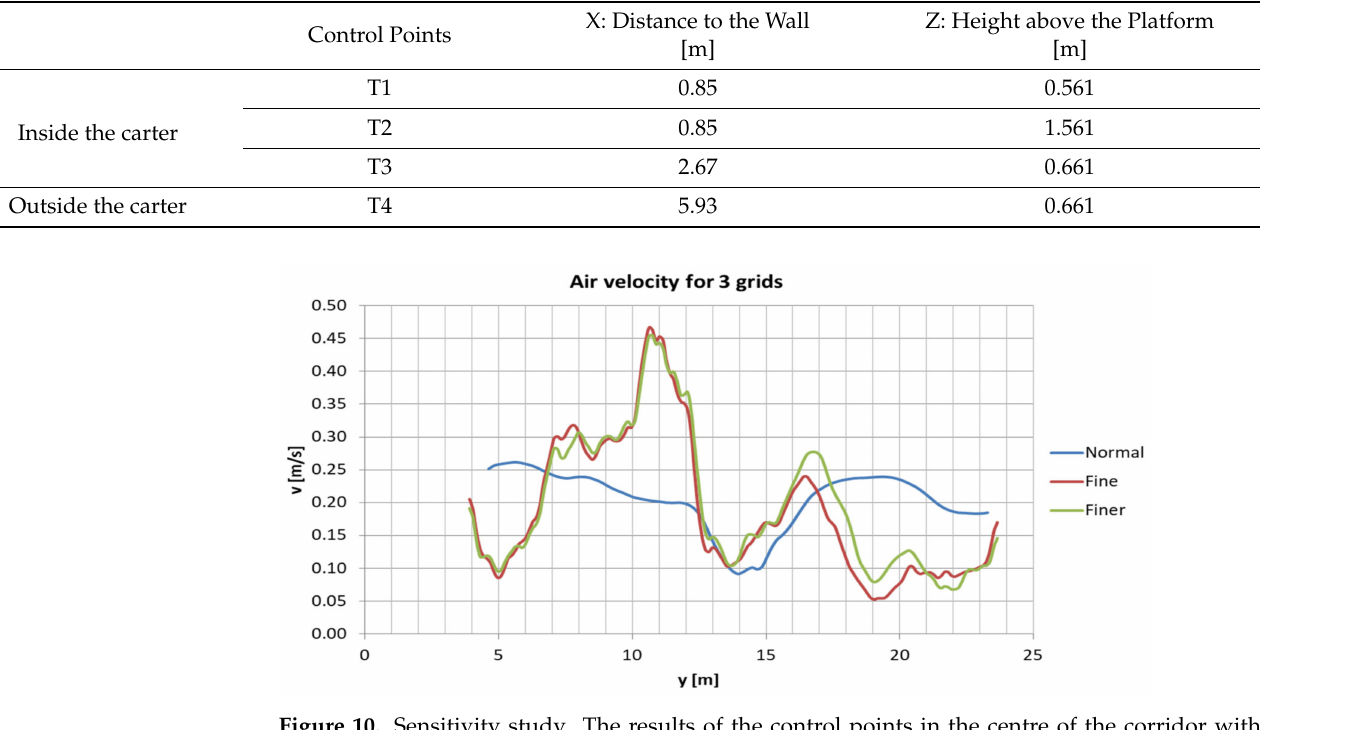
Figure 10. Sensitivity study. The results of the control points in the centre of the corridor with x = 1.5 m, z = 1.56 m are for three different meshes: the normal, the fine and the finer. In the x -axis